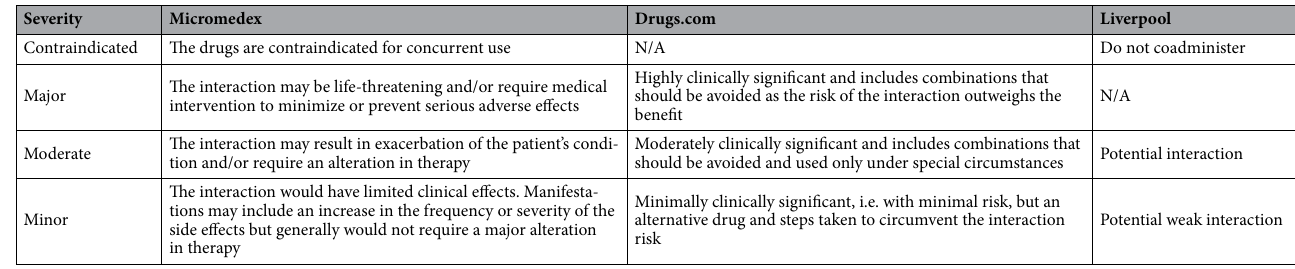
Table 1. Severity classification of potential DDIs determined by the three databases. N/A, not